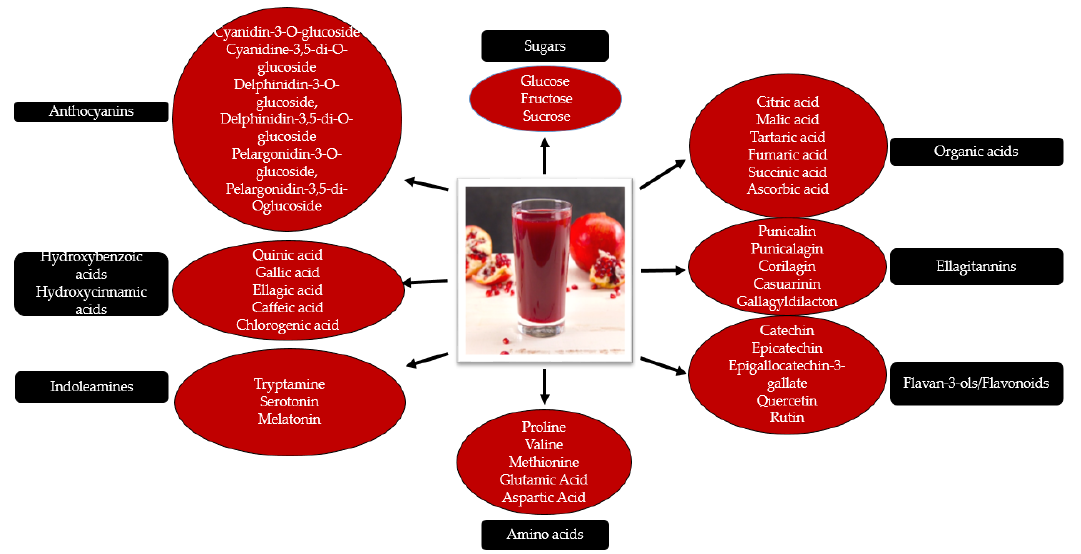
Figure 3. Chemical composition of pomegranate juice.